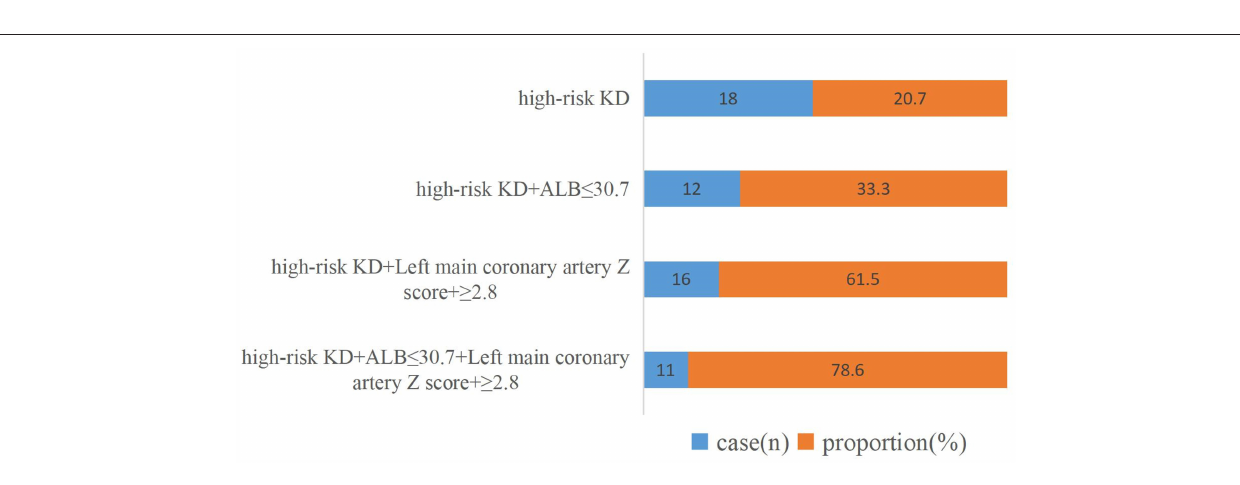
FIGURE 4 | Incidence of coronary artery abnormalities after disease onset per risk factor. KD, Kawasaki disease; ALB, serum albumin